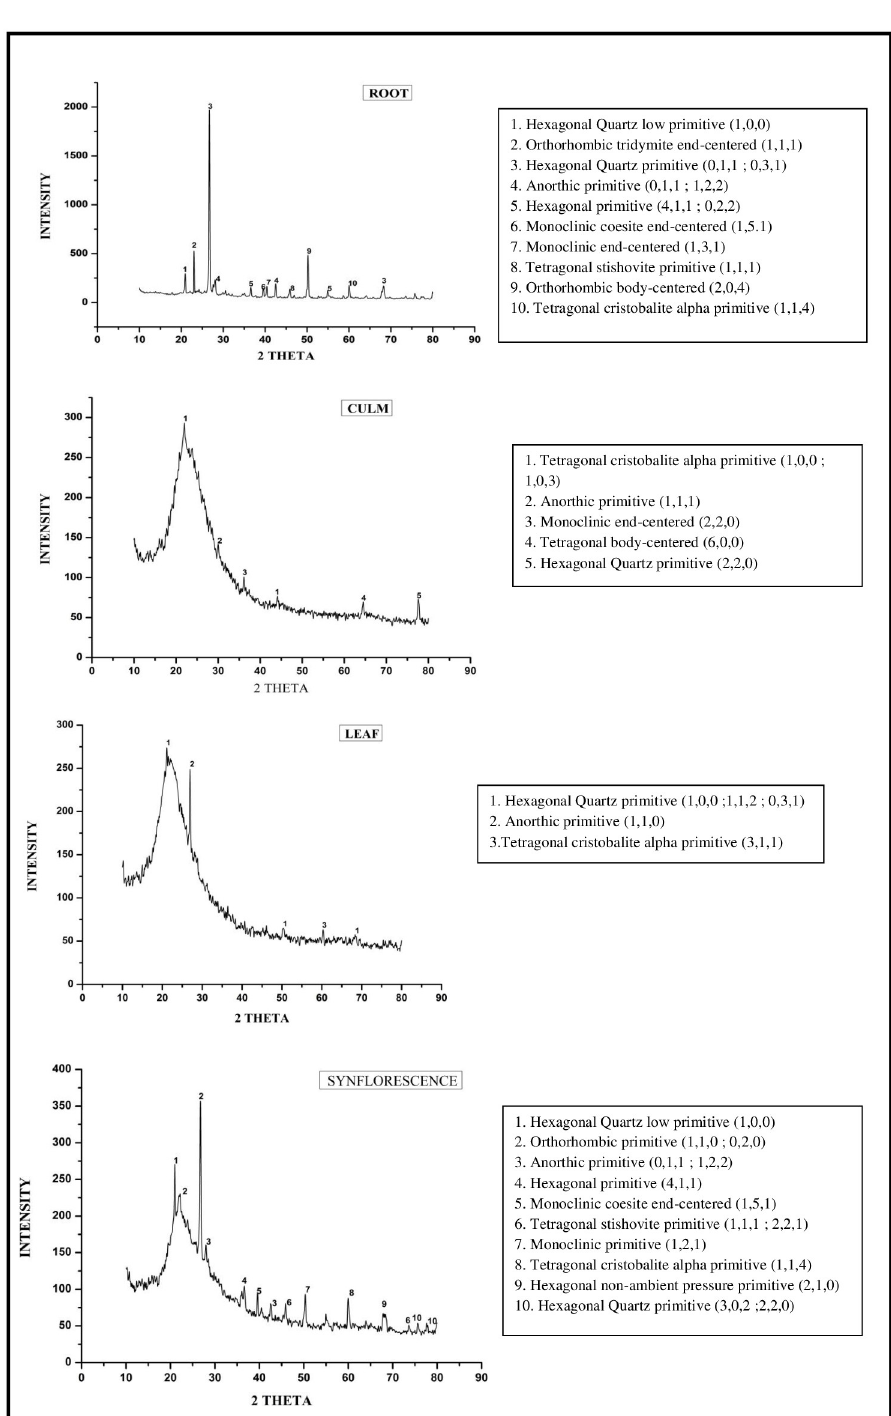
Fig 11. XRD diffraction spectra of phytoliths isolated from different parts of Acrachne racemosa (Heyne ex Roem. & Schult.) Ohwi.